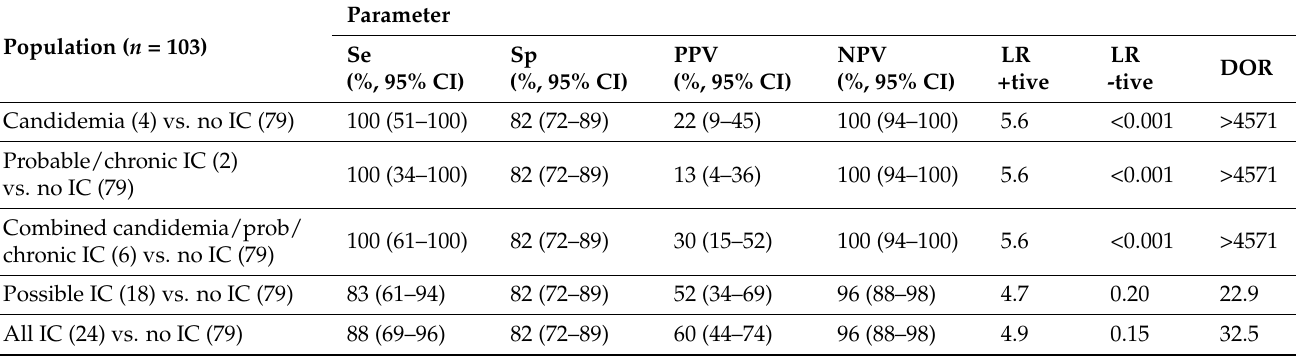
Table 2. Prospective performance of the OLM Cand ID real-time PCR when testing serum with DNA extracted using the Roche MagNA Pure